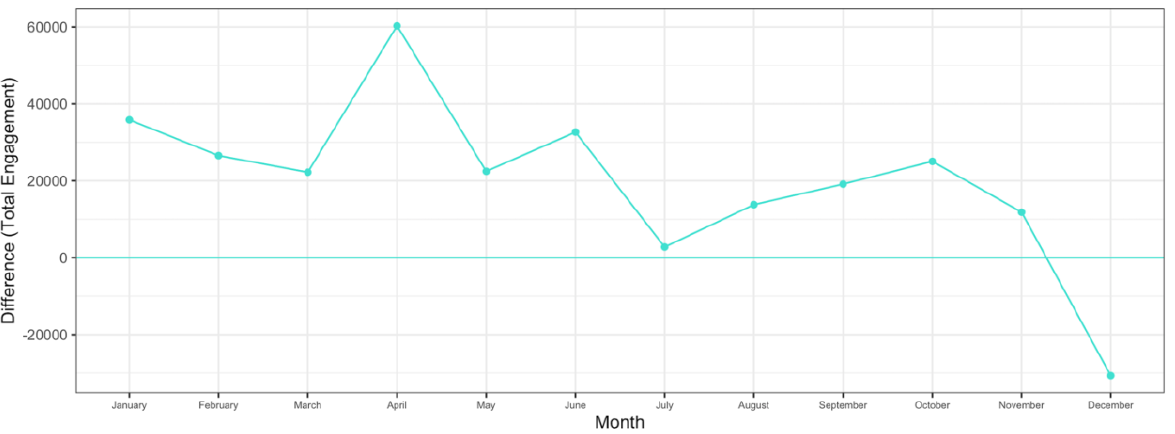
Figure B4. Difference in total engagement by users between 2020 and 2019. Each data point represents the difference between 2020 and 2019 in total engagement for each month. Total engagement for a month was calculated by adding the total engagement for all fact-checking